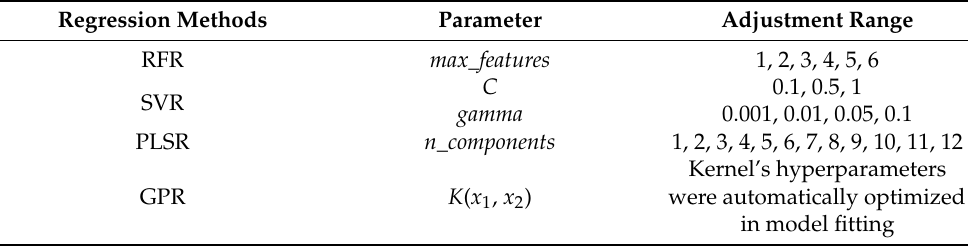
Table 3. The adjustment range of regression methods’ parameters. Regression